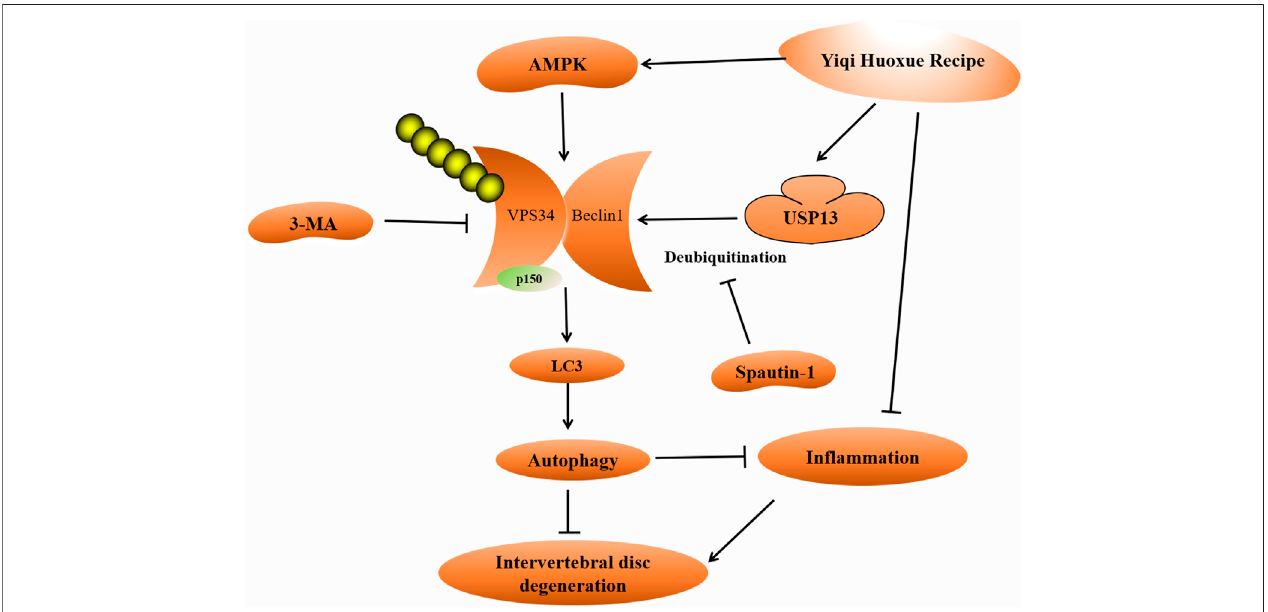
FIGURE 6 | Schematic model of the proposed signaling pathways of the effect of YQHXR in IVDD.